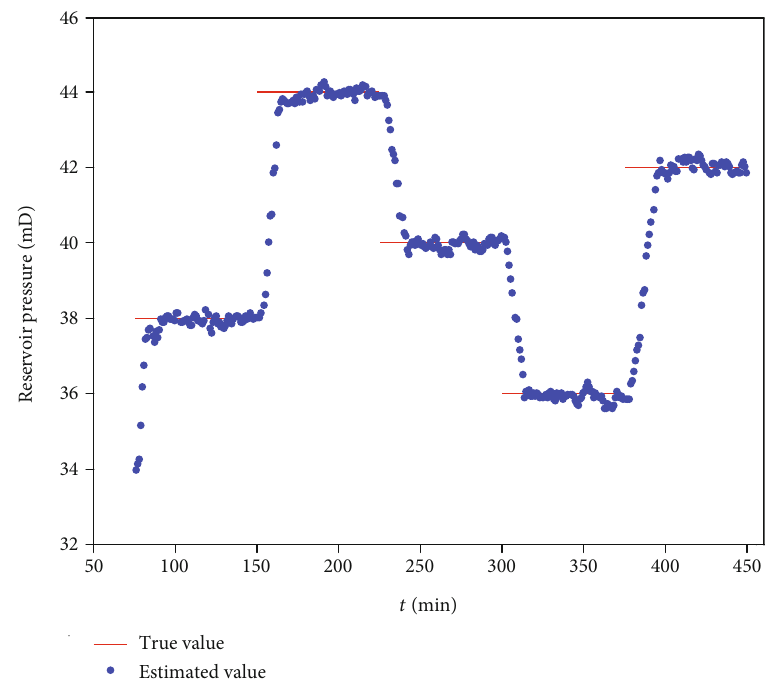
Figure 8: True and estimated reservoir pressure (case 2).